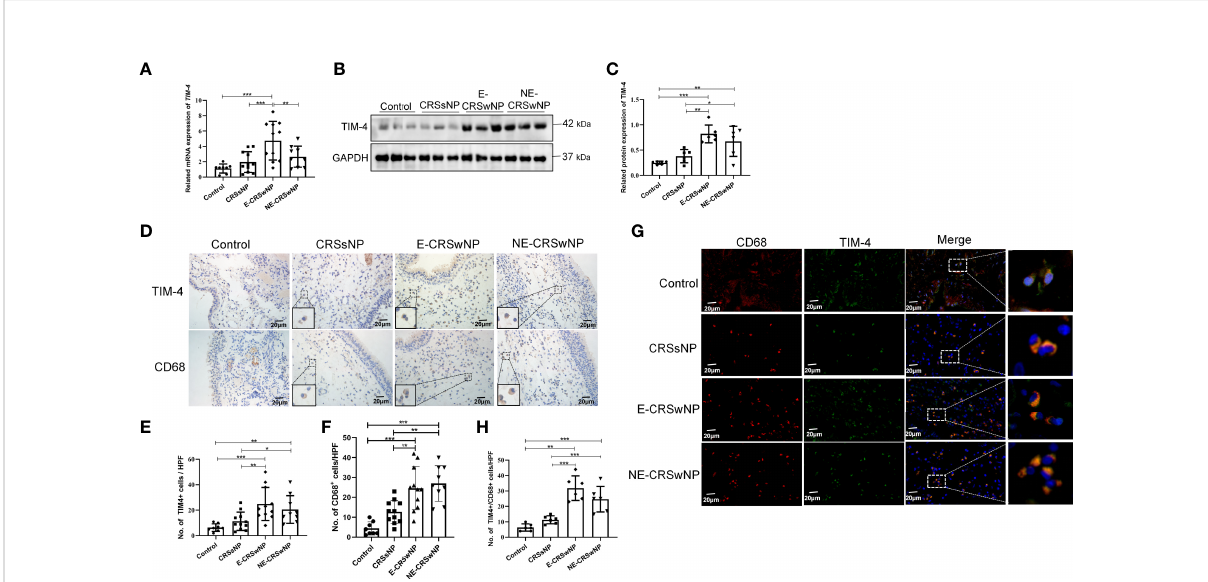
FIGURE 1 Increased TIM-4 expression in macrophages from patients with CRSwNP. (A) The mRNA expression levels of TIM-4 in different human sinonasal mucosae, as detected by quantitative RT – PCR. (B-E) Protein expression levels of TIM-4 in the human sinonasal mucosa. (B) The protein levels of TIM-4 in the human sinonasal mucosa from the control, CRSsNP, E-CRSwNP, and NE-CRSwNP groups, as detected by Western blot analysis. GAPDH was used as a control. (C) Quantitative summary of the relative protein expression of TIM-4. (D) The TIM-4 + cells and CD68 + cells in the human sinonasal mucosa from the control, CRSsNP, E-CRSwNP, and NE-CRSwNP groups were examined by IHC. (E) Quantitative summary of the number of TIM-4 + cells in the human sinonasal mucosa. (F) Quantitative summary of the number of CD68 + cells in the human sinonasal mucosa. (G, H) Colocalization of TIM-4 + and CD68 + in the human sinonasal mucosa. (G) Double immuno fl uorescence staining of TIM-4 (green) and CD68 + macrophages (red) in the lamina propria of human sinonasal mucosa from the control, CRSsNP, E-CRSwNP, and NE-CRSwNP groups. (H) Quantitative summary of the number of TIM-4 + /CD68 + cells in the human sinonasal mucosa. RT – PCR, IHC (control group: n=8; CRSsNP group: n=11; E-CRSwNP group: n=11; NE-CRSwNP group: n=9); Western blot, and immuno fl uorescence (control group: n=6; CRSsNP group: n=6; E-CRSwNP group: n=6; NE-CRSwNP group: n=6). All of the above representative pictures are shown at a magni fi cation 400×, and the insets show a higher magni fi cation of the selected area. Bars show the mean ± SD. *P<0.05,